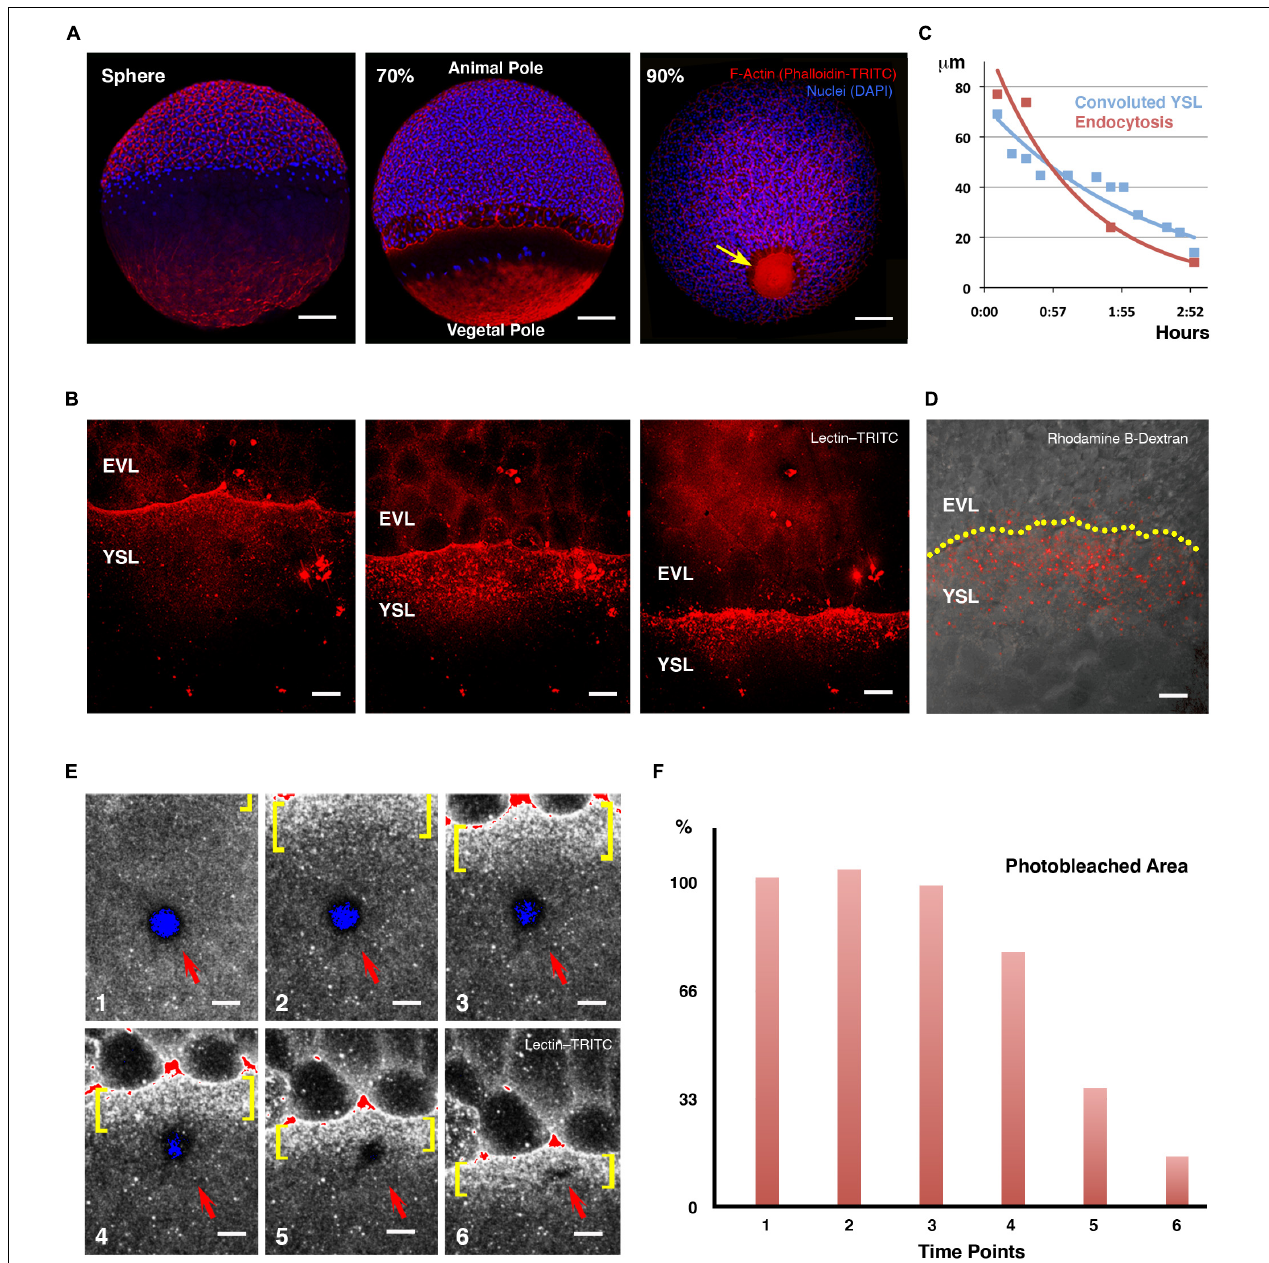
FIGURE 1 | Yolk cell membrane endocytosis at the E-YSL. (A) Blastoderm expansion during epiboly. At sphere stage epiboly has not yet begun (left). F-actin accumulates at the periphery of all cells as well as in the yolk cell, mainly at the vegetal cap. At 70% epiboly (middle), the blastoderm has crossed the equator and will decrease its margin until closure. A belt of actin develops at the E-YSL ahead of the EVL and an actin-free zone separates this belt from a vegetal actin-rich patch. At 90% epiboly (right), the E-YSL and the vegetal actin-rich patch merge at the vegetal pole (arrow). Embryos were stained with phalloidin-TRITC (red) and DAPI (blue). Scale bars 100 µ m. (B) Sequential images of a confocal time-lapse video of a wild type embryo soaked in lectin–TRITC for 5 min at sphere stage. The lectin binds to the membrane of both the yolk cell and the EVL cells and gets internalized accumulating in vesicles in the E-YSL just ahead of the EVL margin (from Supplementary Movie 1 ). EVL and YSL are indicated. Scale bar 25 µ m. All confocal images are maximum projections. (C) Parallel reduction of the width of the convoluted E-YSL domain (blue) and the area undergoing membrane removal (red) during epiboly progression. X and Y axes represent hours after 50% epiboly and width in µ m, respectively. (D) Uptake of fluorescent dextran (red) at the E-YSL just ahead of the EVL margin (yellow dots) at 65% epiboly. Scale bar 25 µ m. (E) Snapshots of time-lapse images (from Supplementary Movie 2 ) of a lectin-TRITC soaked embryo (levels color coded as a range indicator) showing a circular photobleached area (red arrow) in the yolk cell away from the EVL leading edge. The photobleached membrane is removed and endocytosed only upon its enclosure within the advancing E-YSL (yellow brackets). All confocal images are maximum projections. Scale bar 25 µ m. (F) Membrane internalization dynamics. Histograms depicting the percentage of the photobleached area reduction (red) at each regular sequential time points in (E) . The removal of the photobleached membrane initiates once becomes a part of the convoluted area ahead of the leading front (from time 4 onward).